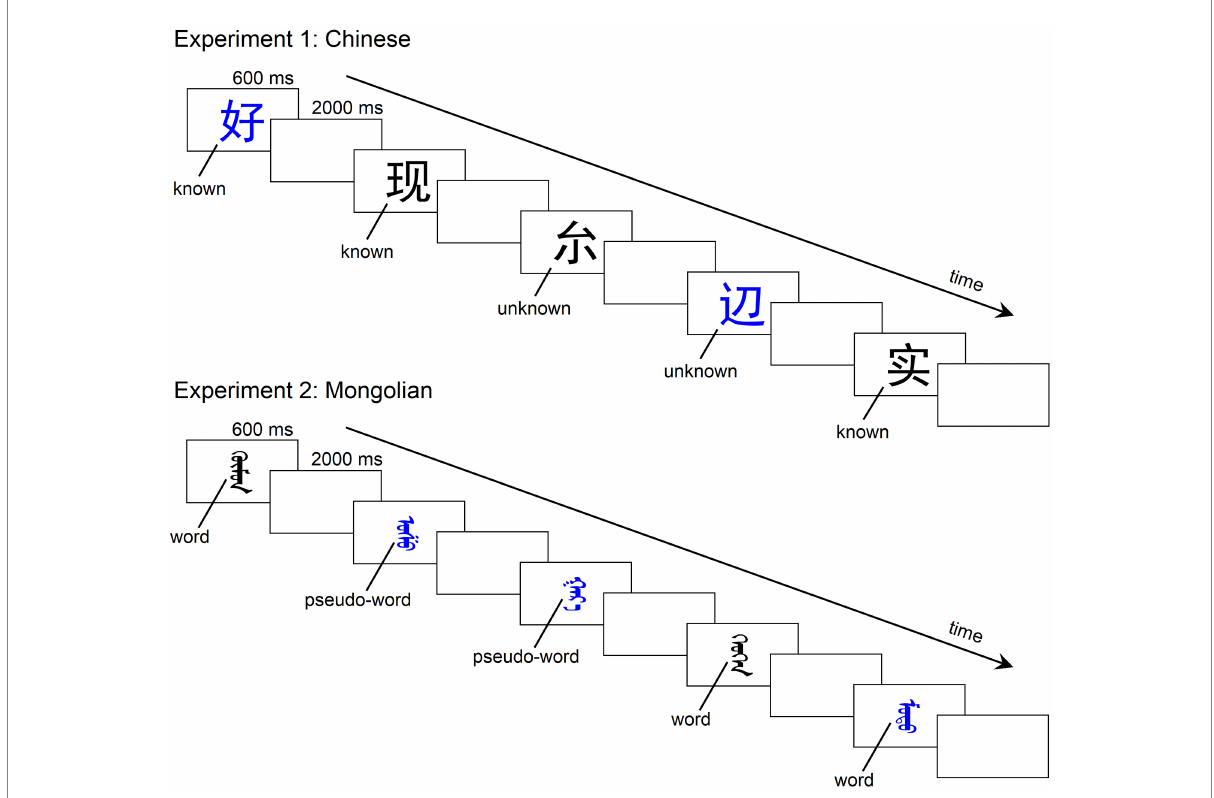
FIGURE 1 Illustration of the experimental procedures. There were two tasks in both experiments: a color decision task and a lexical recognition task. The stimuli were pseudorandomly presented in the center of a monitor with an inter-stimulus interval (offset to onset) of 2,000 ms. The duration of presentation for each stimulus was 600 ms. In the color decision task, participants were asked to determine the color of each stimulus as quickly as possible by pressing two buttons (one for blue and the other for black). In the lexical recognition task, participants were asked to press two buttons to indicate whether s/he knew the